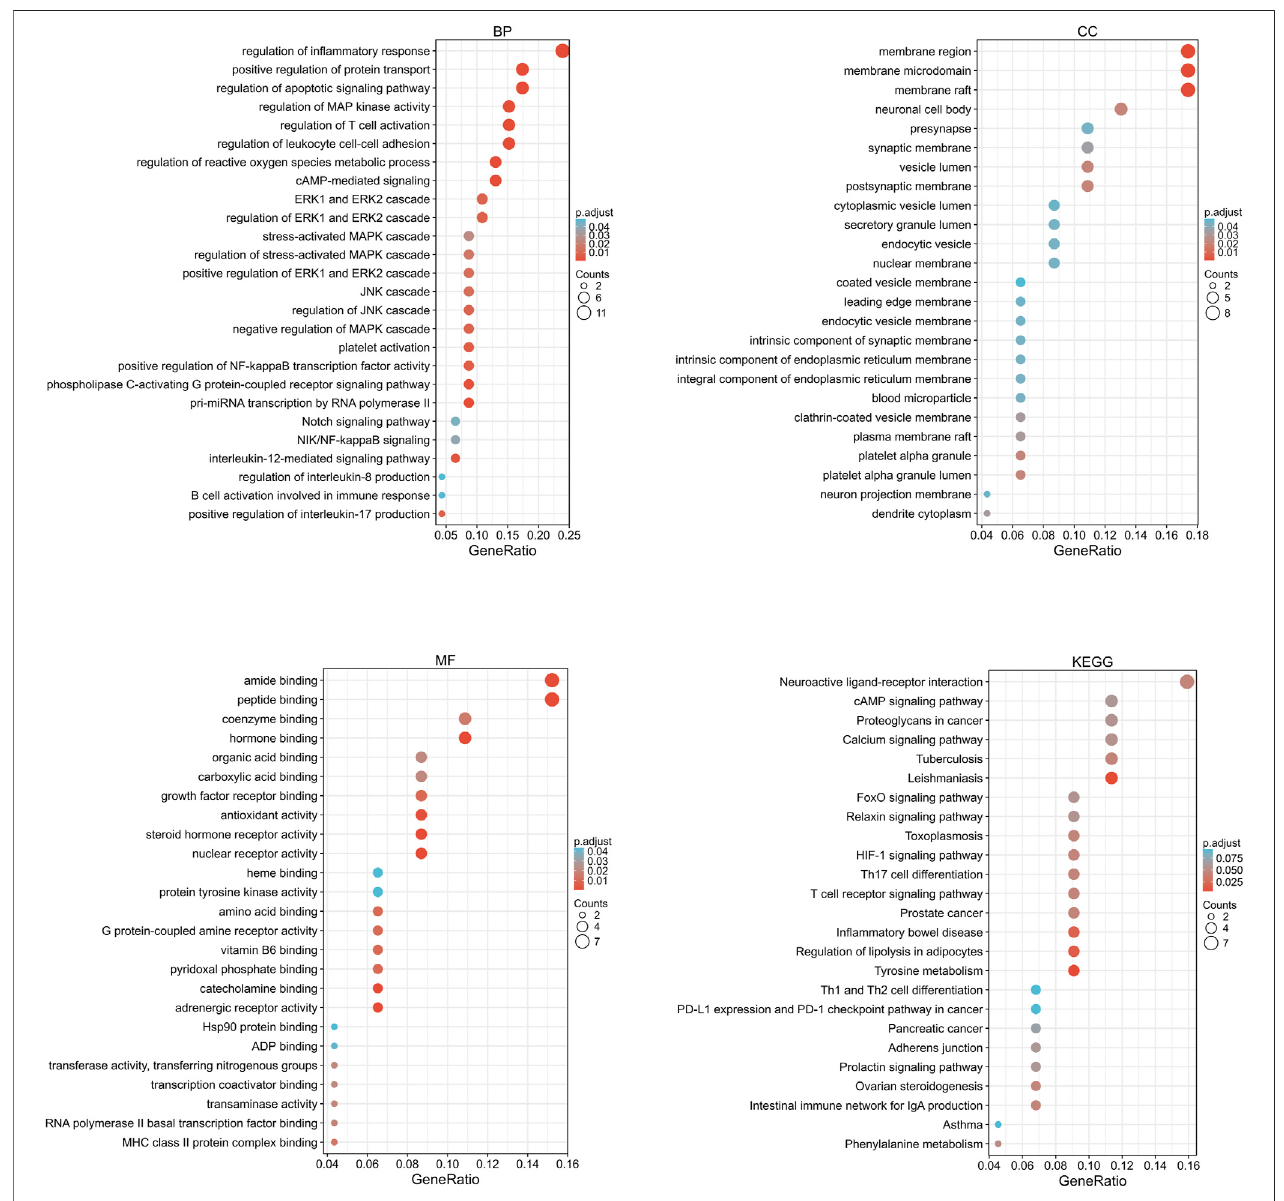
FIGURE 4 | Drug component – target GO function annotation and KEGG pathway enrichment analysis. BP, biological process; CC, cellular component; MF, molecular function.